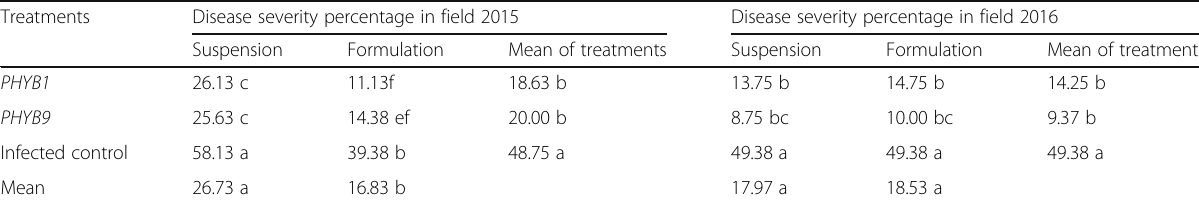
Table 2 Effect of Bacillus simplex as suspension and/or formulation on disease severity under field conditions in 2015 and 2016 growing